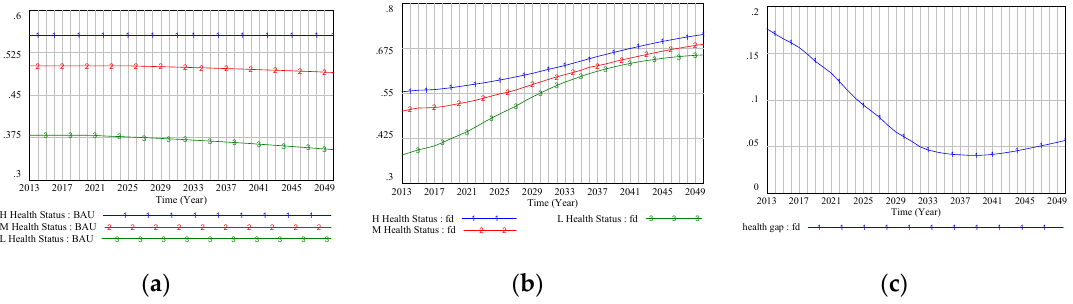
Figure 4. ( a ) Health status (business-as-usual (BAU) scenario); ( b ) health status (FD scenario); ( c ) health gap (FD scenario). Note: BAU scenario: SES–health disparity scenario; FD scenario: SES–FD–health disparity scenario; Policy 1 scenario: scenario with intervention policy of lower drug prices; Policy 2 scenario: scenario with intervention policy of higher income promotion for the low-SES group; Policy hybrid scenario: scenario with two intervention policies.